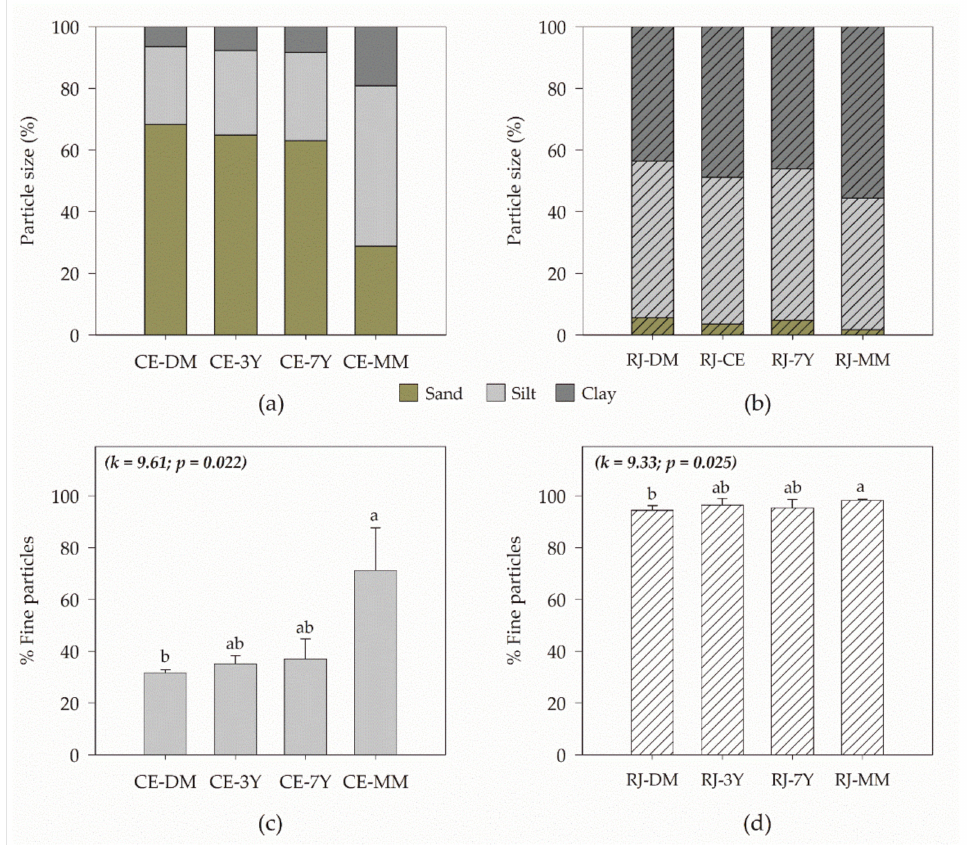
Figure 2. Particle size distribution in mature mangroves, degraded plots, and 3- and 7-year-old plan- tations in Cear á ( a ) and Rio de Janeiro ( b ). ( c ) Fine particle (silt + clay) contents in degraded, mature, and replanted mangrove forests from the Cear á and ( d ) Rio de Janeiro sites. Different lowercase letters indicate significant differences among fine particle contents found by the Kruskal–Wallis test at the 5% probability level, and k values above the critical k (7.8147) indicate statistical